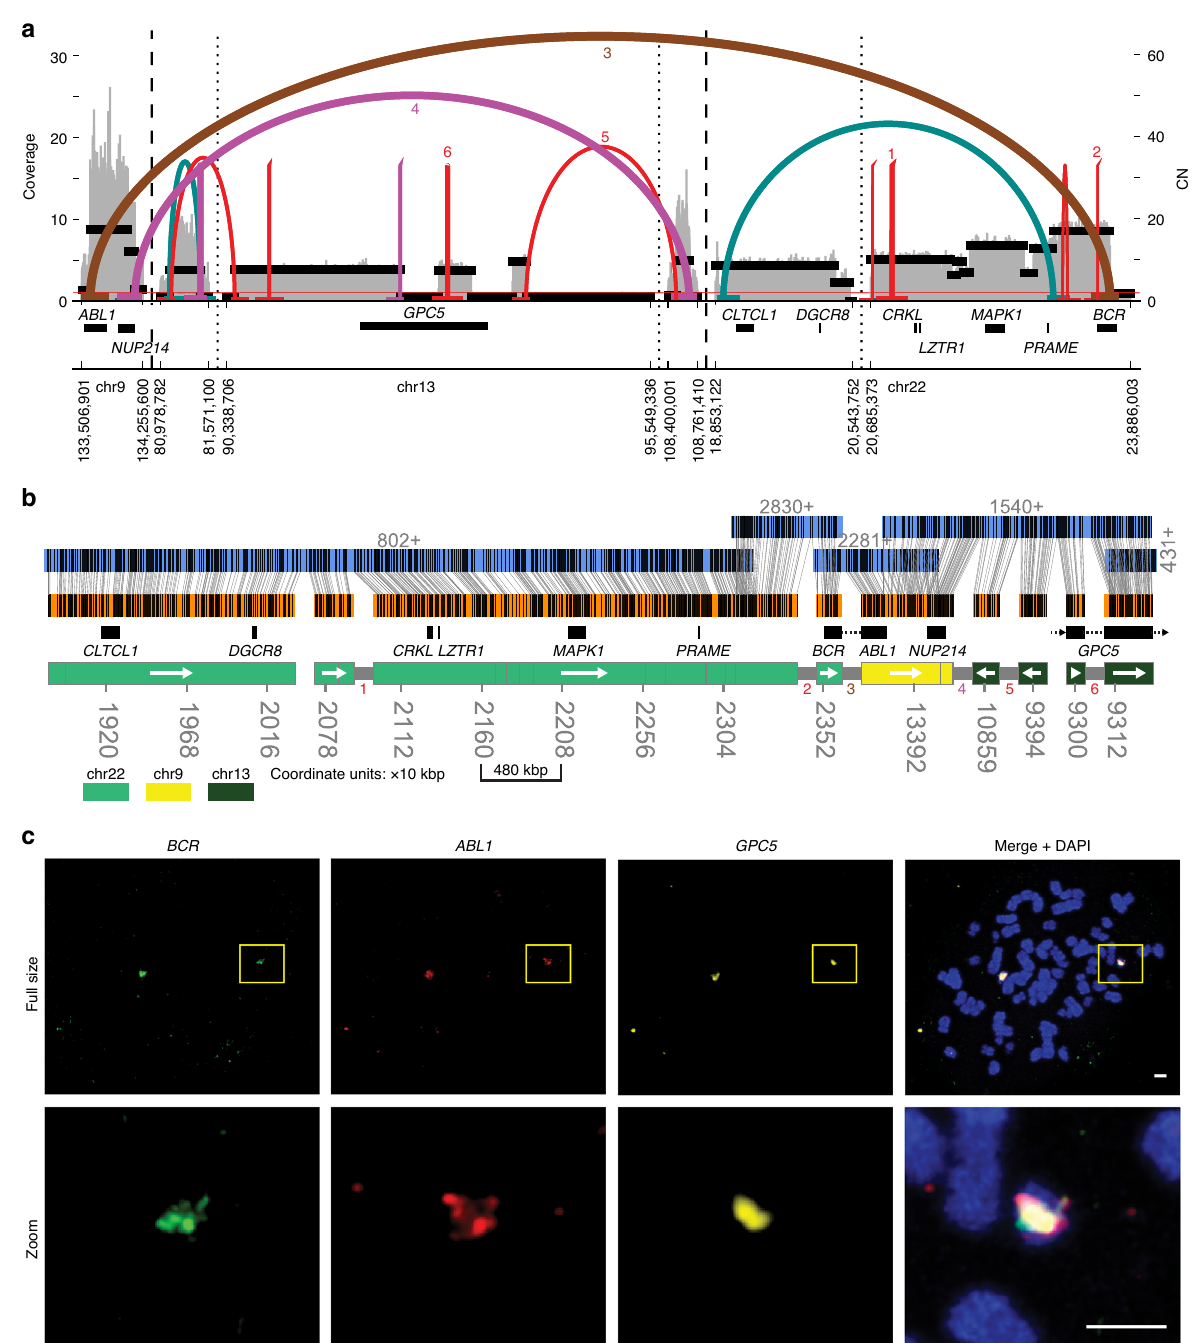
Fig. 3 Reconstruction of a complex Philadelphia chromosome. a AA-generated breakpoint graph for K562. Estimated copy number (CN), coverage, discordant reads forming breakpoint graph edges, and a subset of the genes in these regions are shown. b AR reconstruction of an 8.5 Mbp focal ampli fi cation which was supported by both Irys and Saphyr reconstructions. The tracks from top to bottom are: OM contigs (with contig ID and direction indicated above), graph segments (alignments shown with vertical gray lines), gene subset, and color-coded reference genome bar with genomic coordinates (scaled as 10 kbp units). Gray half-height bars between individual segments on the reference genome bar indicate support from edges in the AA breakpoint graph. White arrows inside the chromosome color bar indicate direction of genomic segment(s). Colored numbers correspond to numbered breakpoint graph edges in panel ( a ). c Multi-FISH using probes against BCR , ABL1 , and GPC5 with DAPI-stained metaphase chromosomes. Scale bars indicate 2 µ m in both “ Full size ” and “ Zoom ”